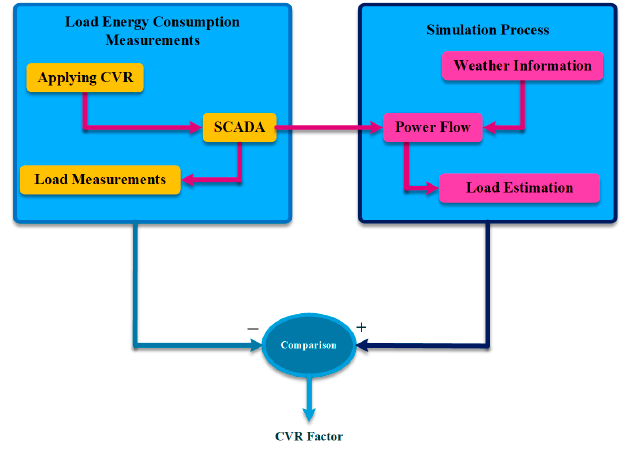
Figure 15. Structure of the simulation-based CVR quantification method [107].